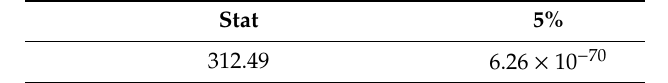
Table 4. The white noise test results of the water consumption data di ff erence at monitoring point 1. Stat